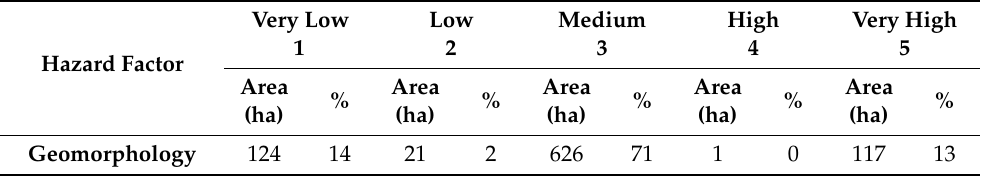
Table 22. Areas and percentages of the study area classified as each class of the geomorphology hazard